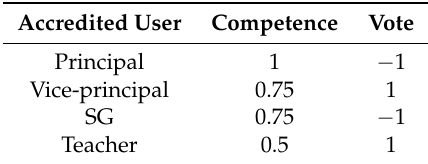
Table 6. Decision-making Accredited User.